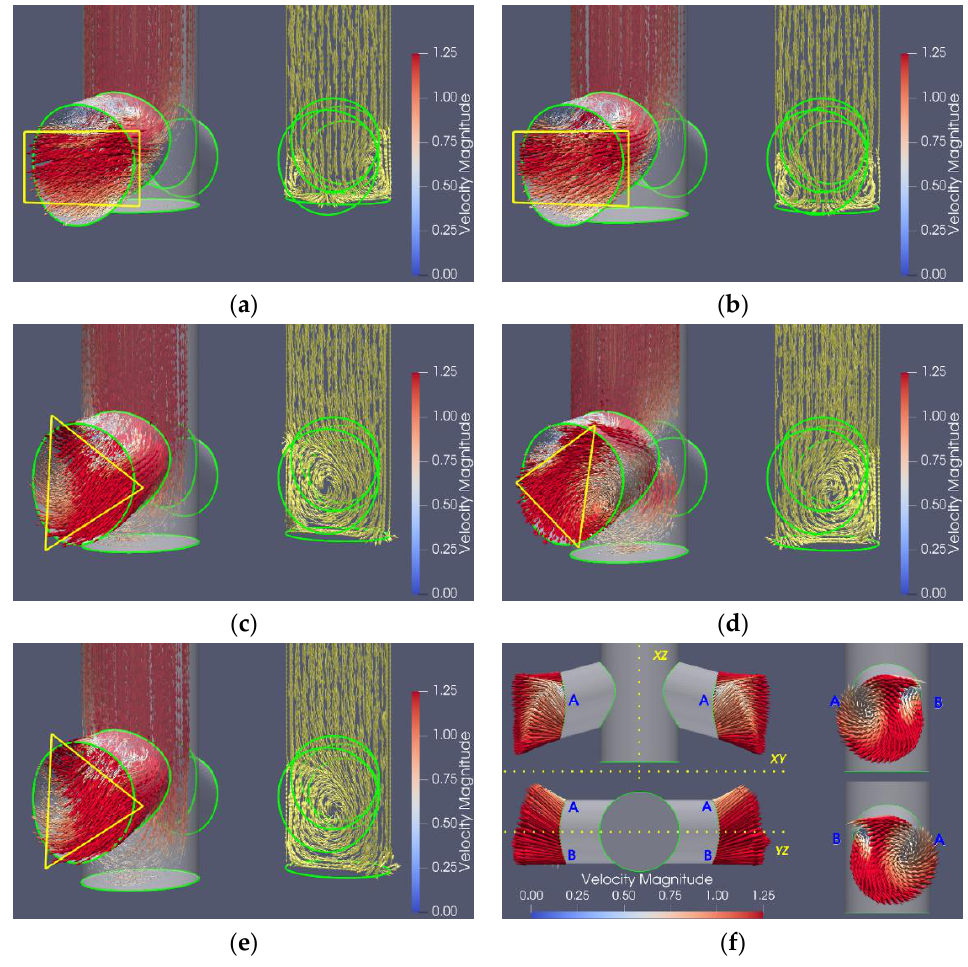
Figure 6. Hydrodynamic behavior inside WB-nozzles with different well-depths: ( a ) 2 mm of well depth, WB-02, ( b ) 4 mm of well depth, WB-04, ( c ) 6 mm of well depth, WB-06, ( d ) 8 mm of well depth, WB-08, ( e , f ) 10 mm of well depth, WB-10. The letters A and B label the exit ports’ sides.